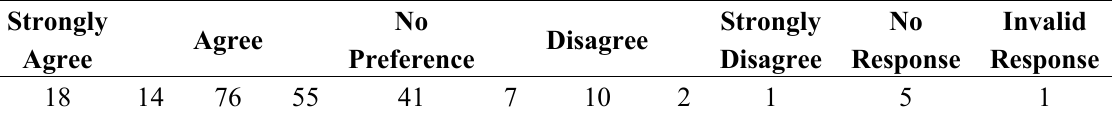
Table 9. Responses to the statement “I would trust computer analysis of data if data sets used for analysis were occasionally (at random time intervals) sent back with the analysis results for verification”.